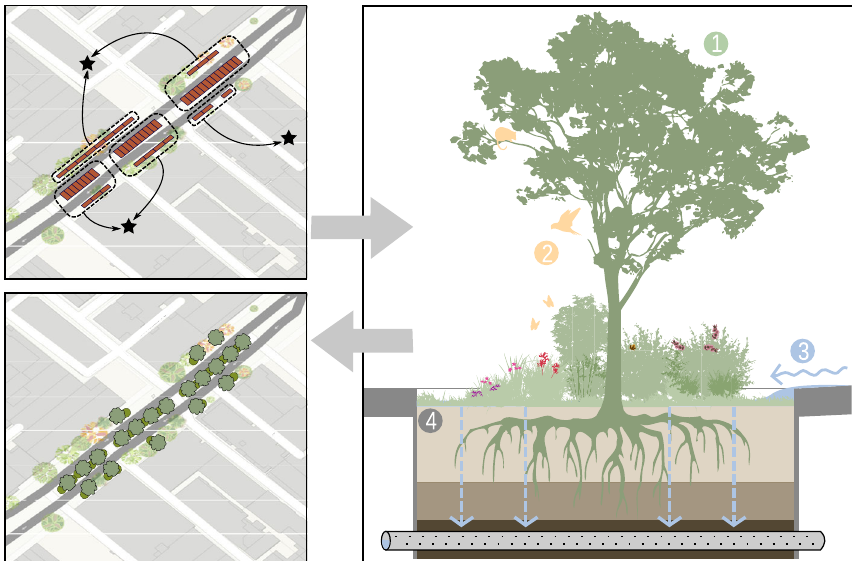
Fig. 1 Summary of the process used to estimate the bene fi ts of replacing redundant on-street carparking with biodiverse green space. On-street car parks close to parking garages with vacancy are identi fi ed and reallocated. Then, redundant street parking is replaced by biodiverse green space, as per the schematic design shown, which integrates a street tree (1), habitat resources such as understorey plants (2), stormwater in fi ltration using a sunken ‘ raingarden ’ design (3), and effectively de-paves the area of the parking space (4). Lastly, the bene fi ts of this change in land use across the City of Melbourne are estimated in terms of tree canopy, ecological connectivity, interception and treatment of stormwater fl ows, and total area of impermeable asphalt removed